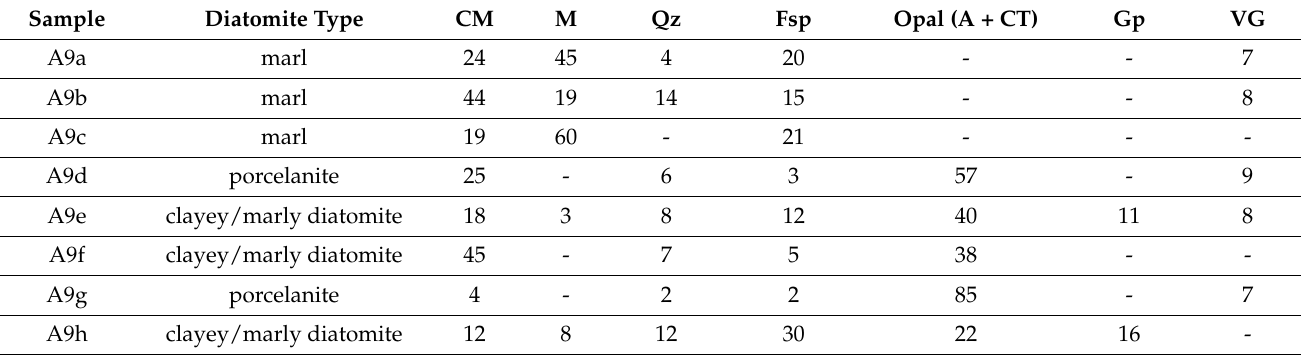
Table 1. Mineralogical composition ( w / w %) of the studied samples as measured by